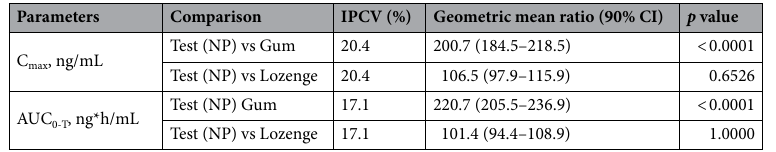
Table 3. Statistical analysis of plasma nicotine PK parameters among adult smokers after single oral product use of three nicotine products under fasting condition. CI confidence interval, IPCV intra-participant coefficient of variation.